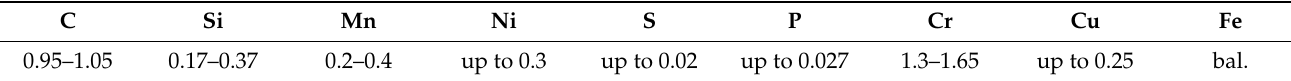
Table 1. Chemical composition (wt.%) of 52,100 steel.